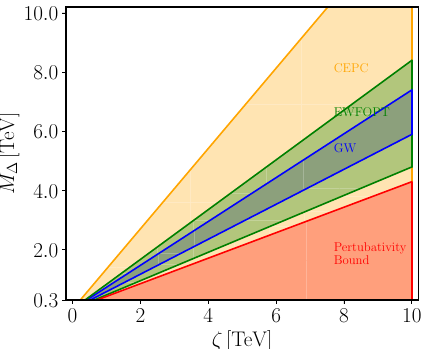
Fig. 4 Parametric regions of the mass of the triplet M (cid:4) [ TeV ] and ζ [ TeV ] = (μ (cid:4) / 3 ) 1 / 3 k 2 / 3 (cid:4) allowing FOPT (green) and GW detectable in LISA, u-DECIGO, BBO (blue), in comparison with CEPC test capa- bility (orange). The exclusion region from the perturbativity bound for (cid:4) -couplings is displayed (red)